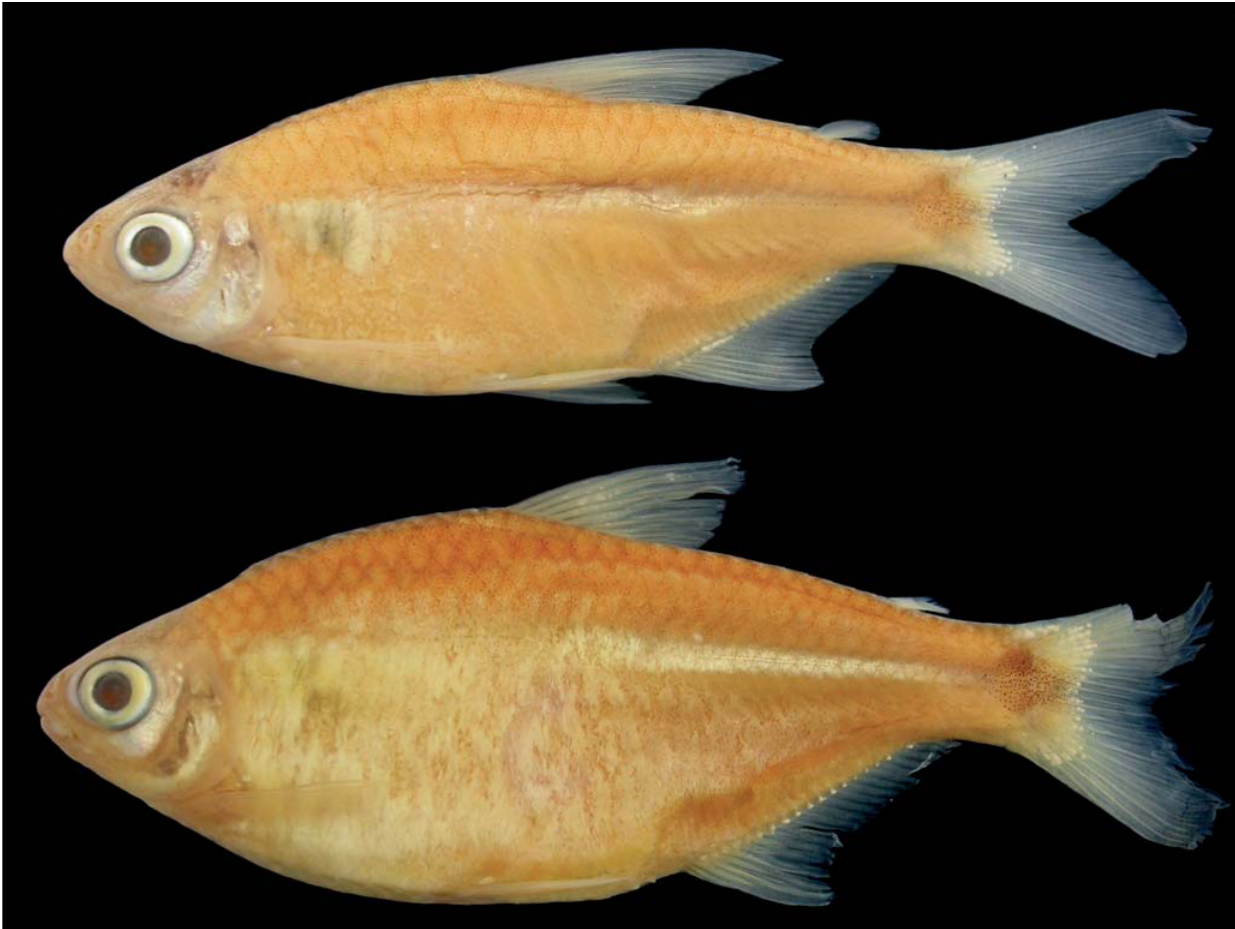
Fig. 12. Holotype of Odontostilbe splendida , ANSP 181040, male 32.7 mm SL (top), and paratype ANSP 181041, female 32.1 mm SL